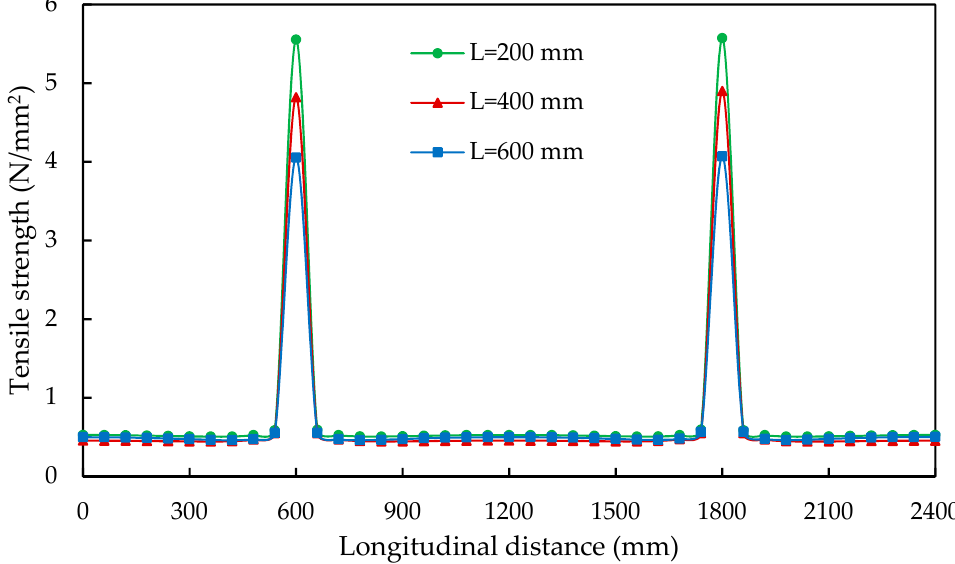
Figure 14. Comparison of maximum concrete tensile stress over the saw-cut tips along the length of concrete slab for different saw-cut lengths.